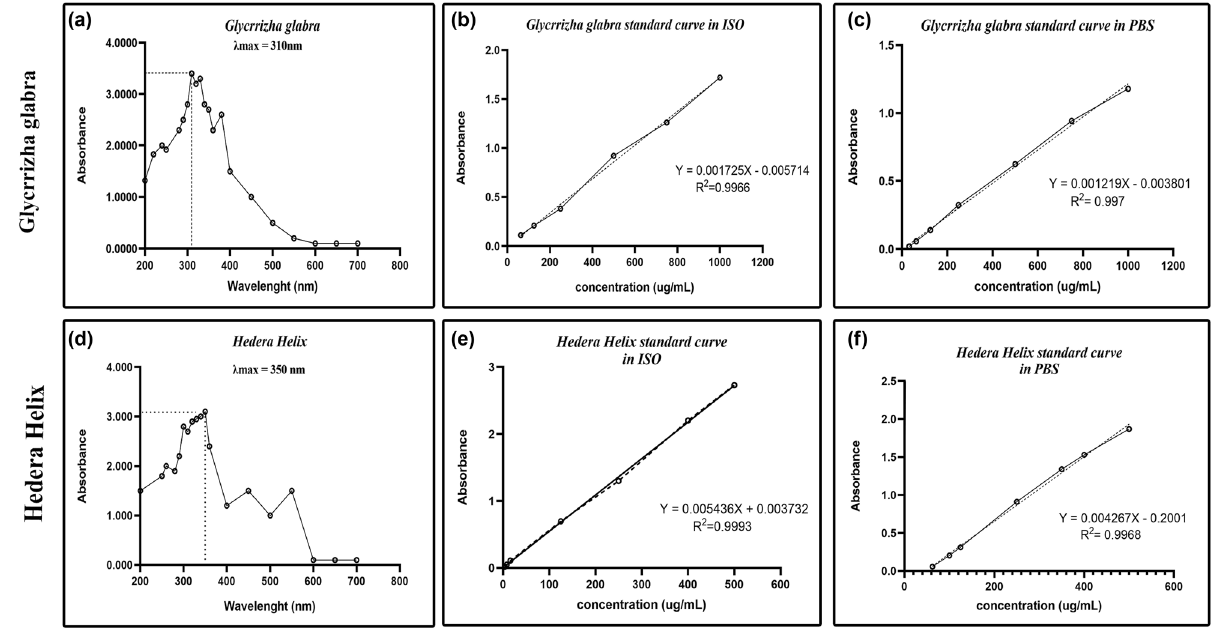
Figure 1: The data obtained from spectrophotometry analysis. ( a ) Maximum wavelength of GGE is at 310 nm. ( b ) Standard curve of GGE in Isopropyl bu ff er, the equation line is Y = 0.001725 X − 0.005714 and R 2 = 0.9966. ( c ) Standard curve of GGE in PBS bu ff er, the equation line is Y = 0.001219 X − 0.003801 and R 2 = 0.997. ( d ) Maximum wavelength of HHE is at 350 nm. ( e ) Standard curve of HHE in Isopropyl bu ff er, the equation line is Y = 0.005436 X + 0.003732 and R 2 = 0.9993. ( f ) Standard curve of HHE in PBS bu ff er, the equation line is Y = 0.004267 X − 0.002001 and R 2 =